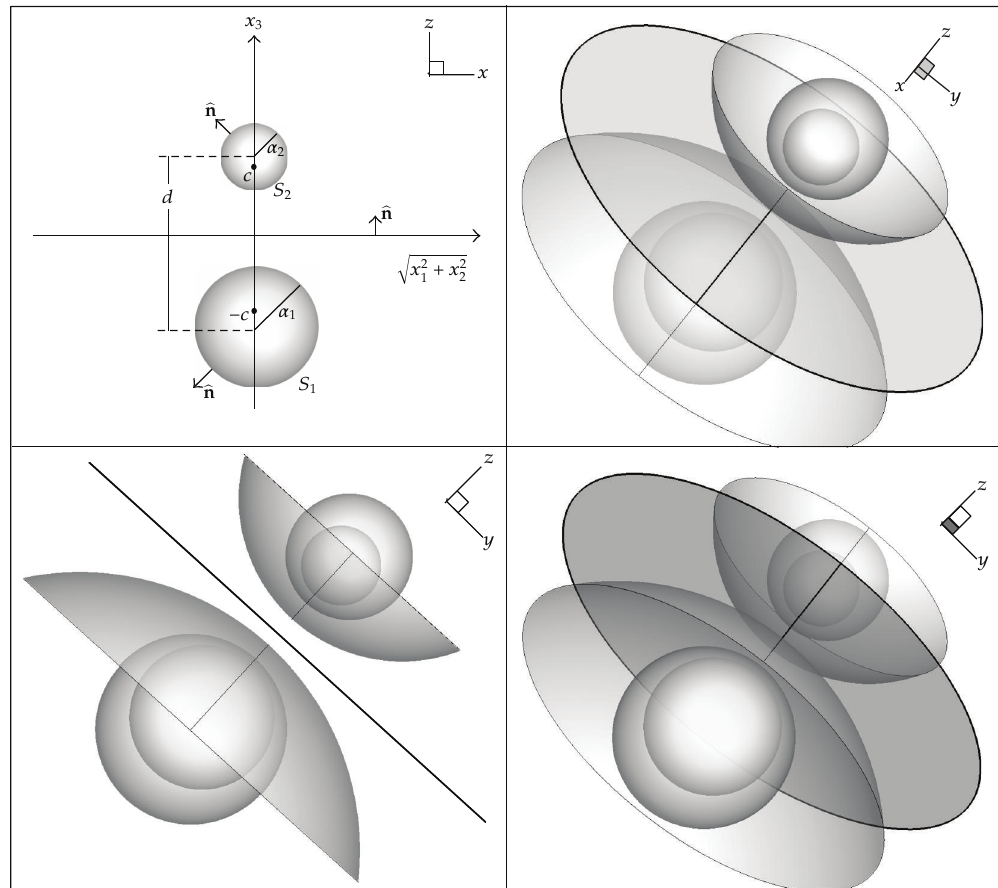
Figure 1: The bispherical coordinate system in the three-dimensional space V (cid:2) R 3 (cid:3) , where the various surfaces depicted correspond to di ff erent values of ζ ∈ R